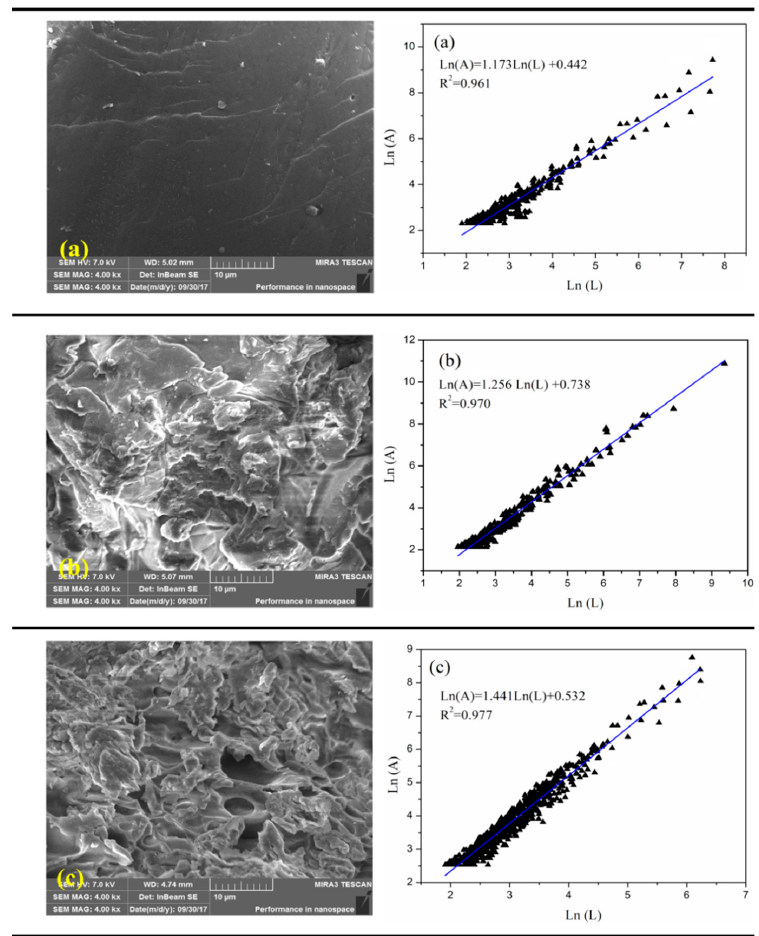
Figure 5. The SEM of ( a ) PAM, ( b ) PAD, and ( c ) PADD.